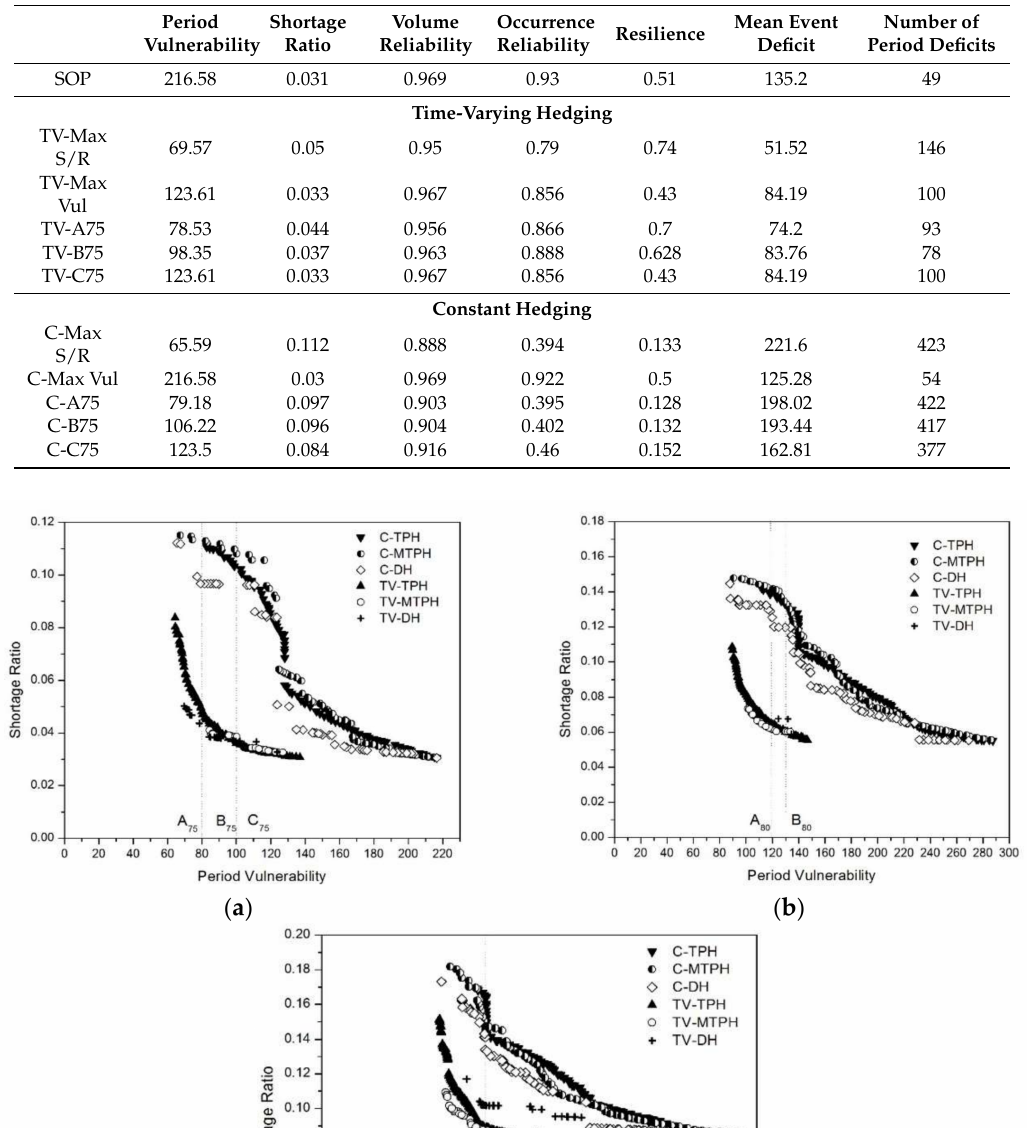
Table 6. Reservoir performance indices at 75% demand level for discrete hedging—a comparison of time-varying and constant hedging policies for selected compromising solutions (see figure 5).